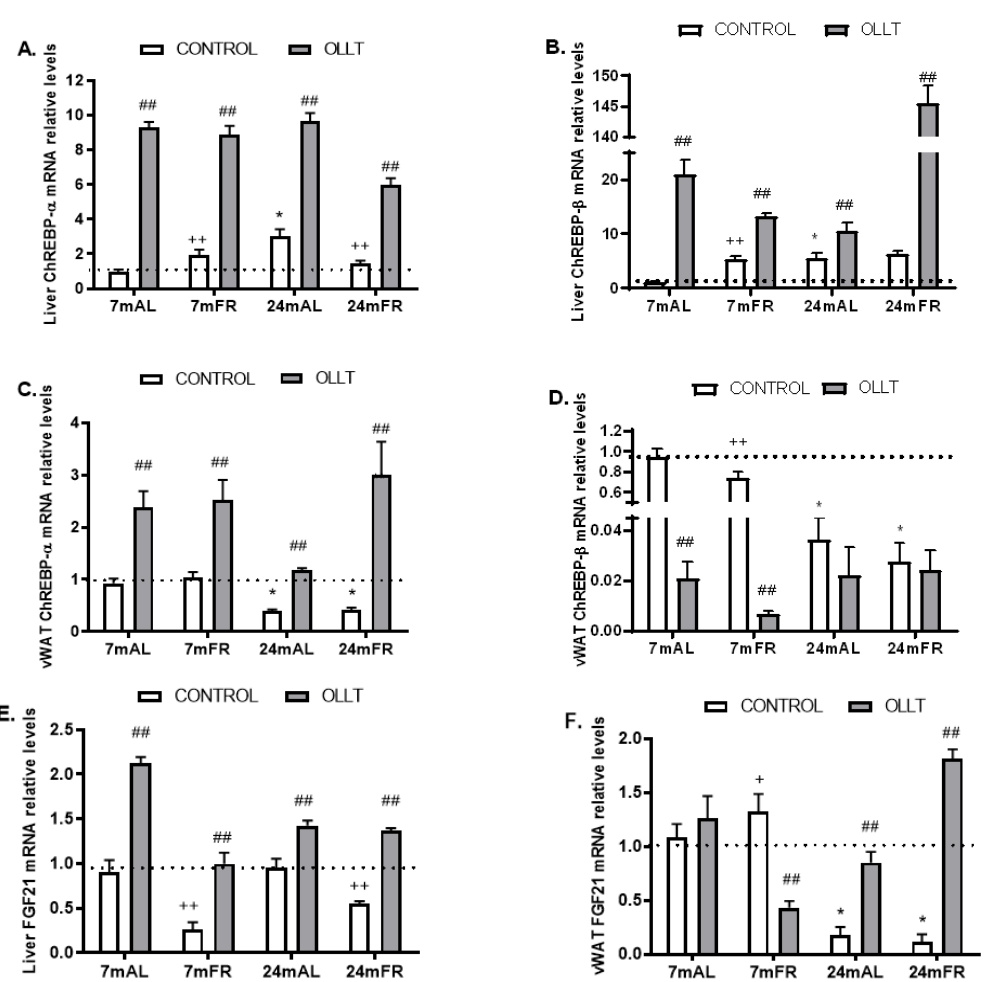
Figure 9. mRNA relative levels of α - and β -ChREBP isoforms in liver ( A , B ), and visceral adipose tissue ( C , D ), in 7- and 24-month-old rats fed ad libitum (AL) or food restricted (FR), before (CONTROL) and after an oral lipid loading test (OLLT); mRNA relative levels of FGF21 in liver ( E ) and visceral adipose tissue ( F ). Results are the mean ± SEM of 8–10 rats per group, made in duplicate. * p < 0.05 compared to 7-month-old rats under the same feeding protocol; + p < 0.05, ++ p < 0.0001 compared to age-matched ad libitum fed rats; ## p < 0.0001 compared to basal levels before a fat load of age-matched rats under the same feeding protocol.